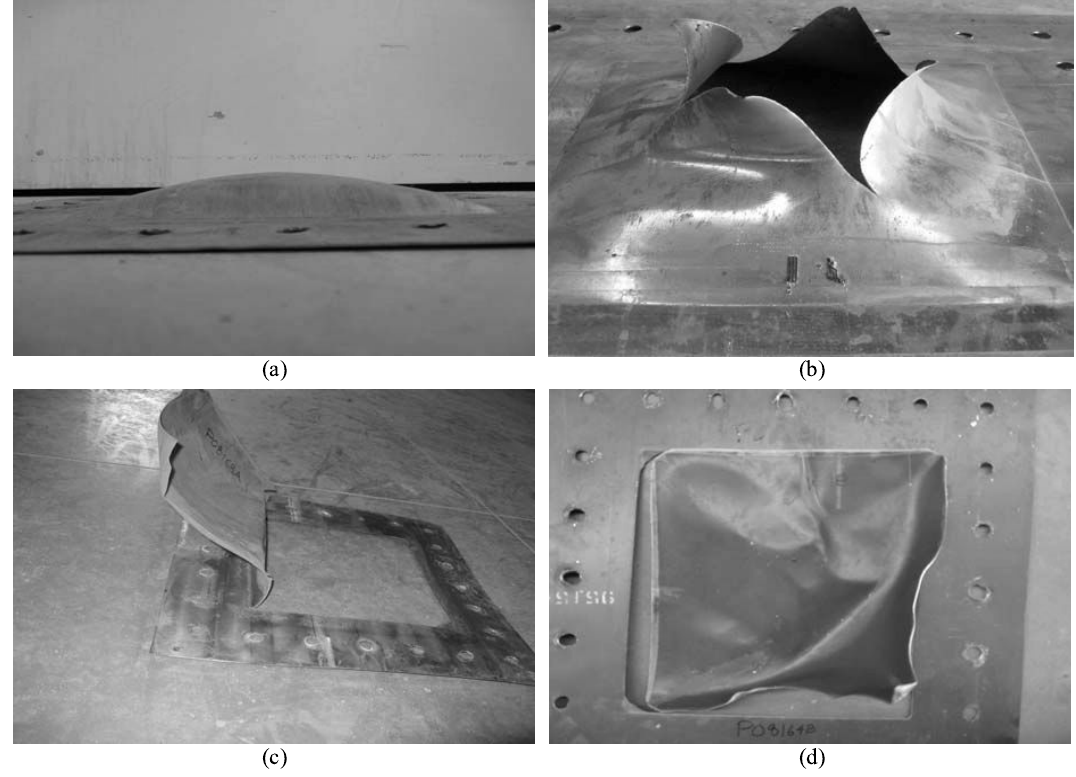
Fig. 6. Different modes of plate damage: a) deformation, b) holing and petaling, c) partial edge rupture, and d) complete edge